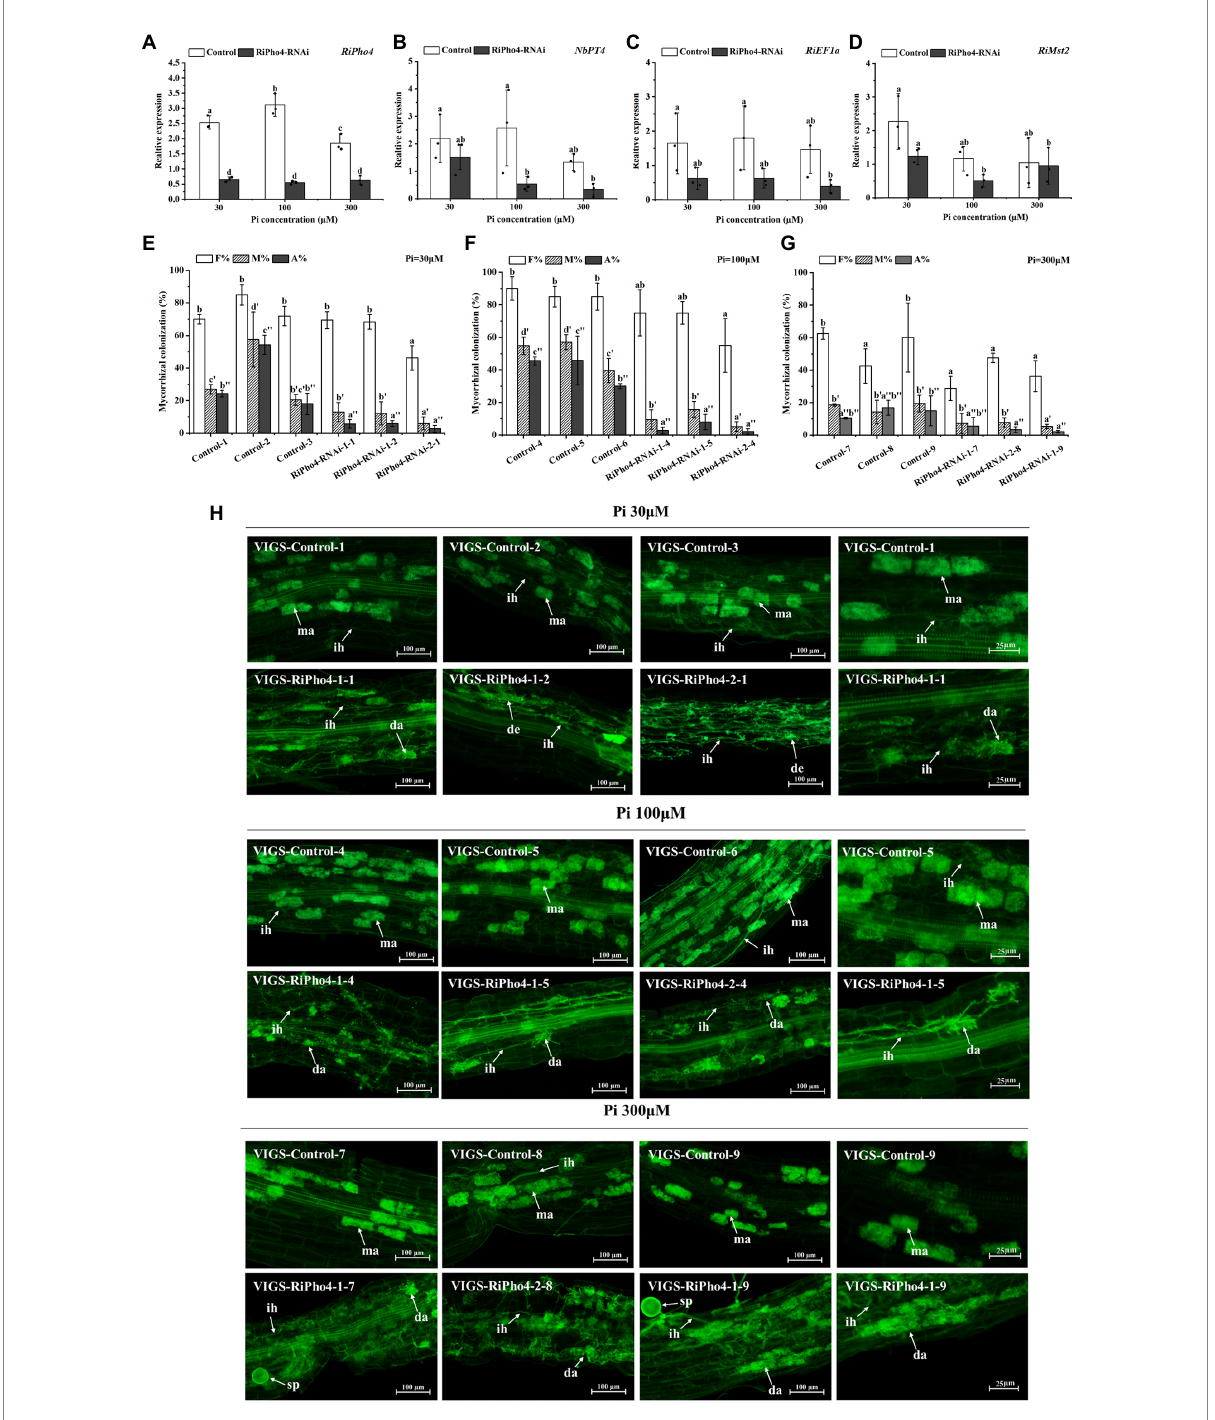
FIGURE 6 Molecular and arbuscular mycorrhizal phenotypes of virus-induced gene silencing (VIGS) of RiPho4 in tobacco ( Nicotiana benthamiana ) roots colonized by R. irregularis grown under different Pi conditions. (A–D) Expression levels of RiPho4 , NbPT4 , RiEF1 α and RiMst2 in mycorrhizal tobacco RiPho4-RNAi roots under different phosphate conditions, estimated by quantitative RT-PCR. R. irregularis RiEF1a and N. benthamiana NbTEF1a were used as the endogenous genes for normalization of RiPho4 , RiMst2 , NbPT4 and RiEF1 α expression, respectively. The data represented the means of three biological replicates. Bars indicated the standard errors of means. Means designated with the same letters are not significantly different ( p ≥ 0.05) according to Duncan’s multiple range test. (E–G) Mycorrhizal colonization levels between the control and RiPho4- RNAi roots exposed to different Pi (30 μ M, 100 μ M and 300 μ M K 2 HPO 4 ) concentrations were determined after the WGA488 staining. F%, the total colonization frequency; M%, the percentage of mycorrhizal intensity; A%, the percentage of arbuscule abundance. (H) Fluorescence microscopic images of R. irregularis arbuscules in control and RiPho4-RNAi roots grown under different Pi conditions. The arrows and letters in the figure represent different structures of R. irregularis : ma, mature arbuscules; da, degraded arbuscules; de, dead arbuscules; ih, intraradical hyphae; sp., spores. Scale bars, 100 μ m (1–3 columns), 25 μ m (the 4th